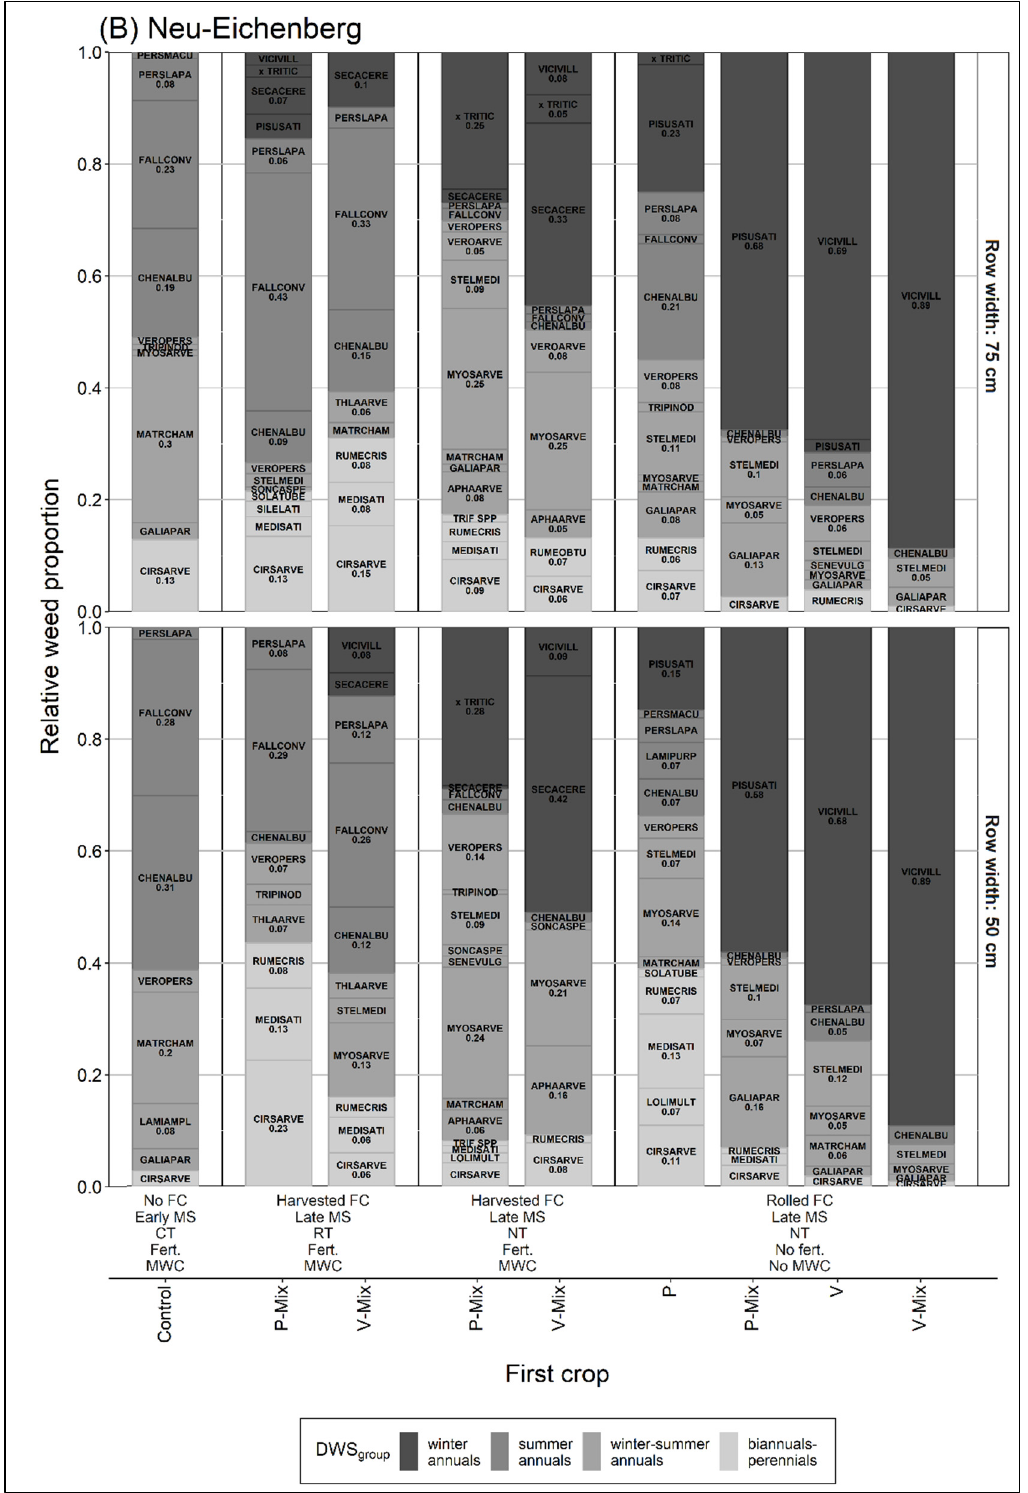
Figure A3. ( A ) Relative proportion of dominant weed species (DWS) at Trenthorst averaged over year . The x-axis shows the first crop factor (P = winter pea, V = hairy vetch, P-Mix = winter pea and cereal mixture, V-Mix = hairy vetch and cereal mixture) grouped horizontally by management (FC = first crop, MS = maize sowing, CT = conventional tillage, RT = reduced tillage, NT = no tillage, Fert. = fertilization, MWC = mechanical weed control) and vertically by row width (75 cm and 50 cm). Colours indicate DWS group . Proportions were related to total DWS based on estimates. Additionally, DCS NT treatments at TRE were only present in the second year. Species are indicated with 4 letters